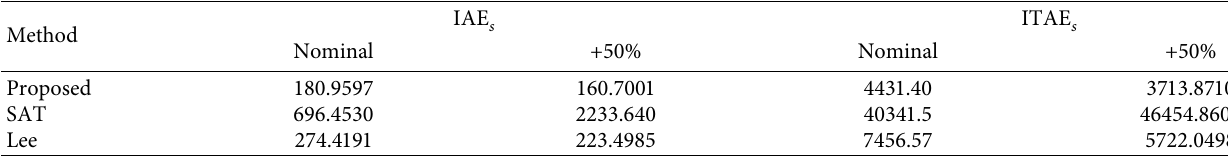
Table 4: Performance indices.